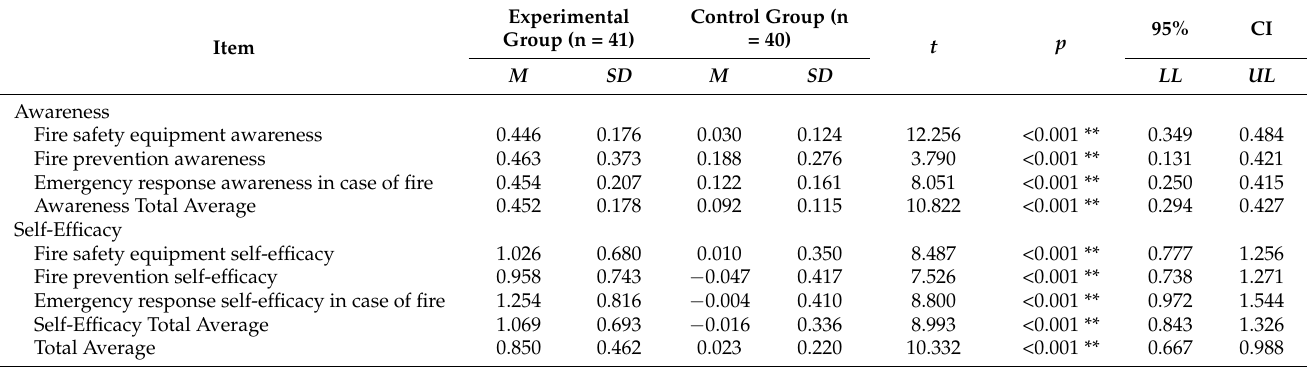
Table 5. Difference analysis of the two groups’ effectiveness in the pretest and post-test (N =